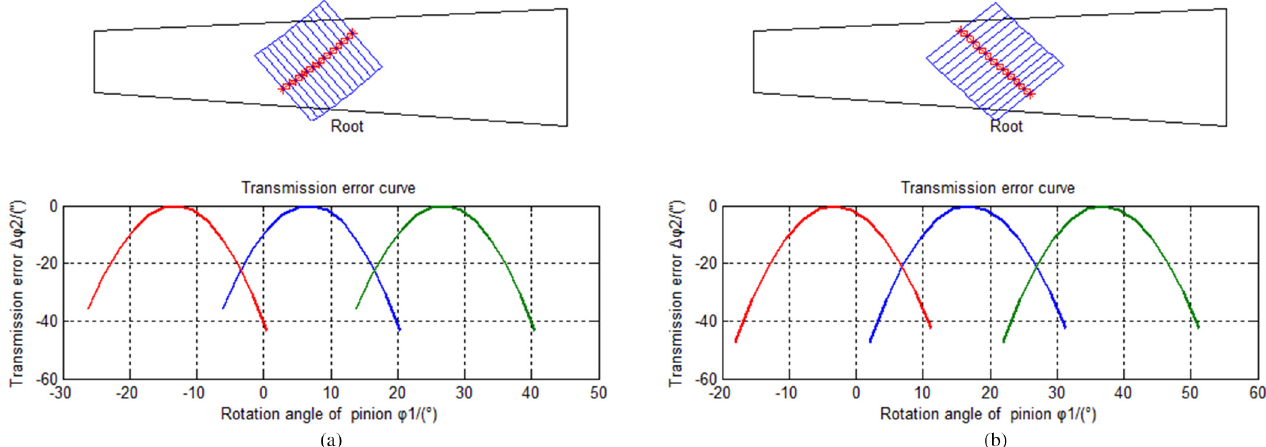
Fig. 7. Result of TCA. (a) Convex side. (b) Concave side.